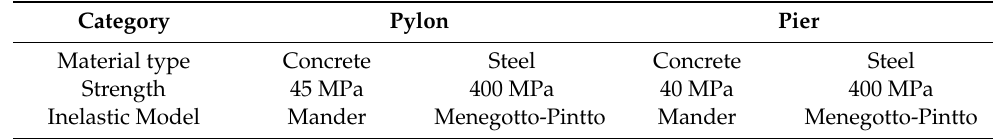
Figure 10. Fibre model for a pylon and piers. Table 7. Non-linear analysis model of fibre members.